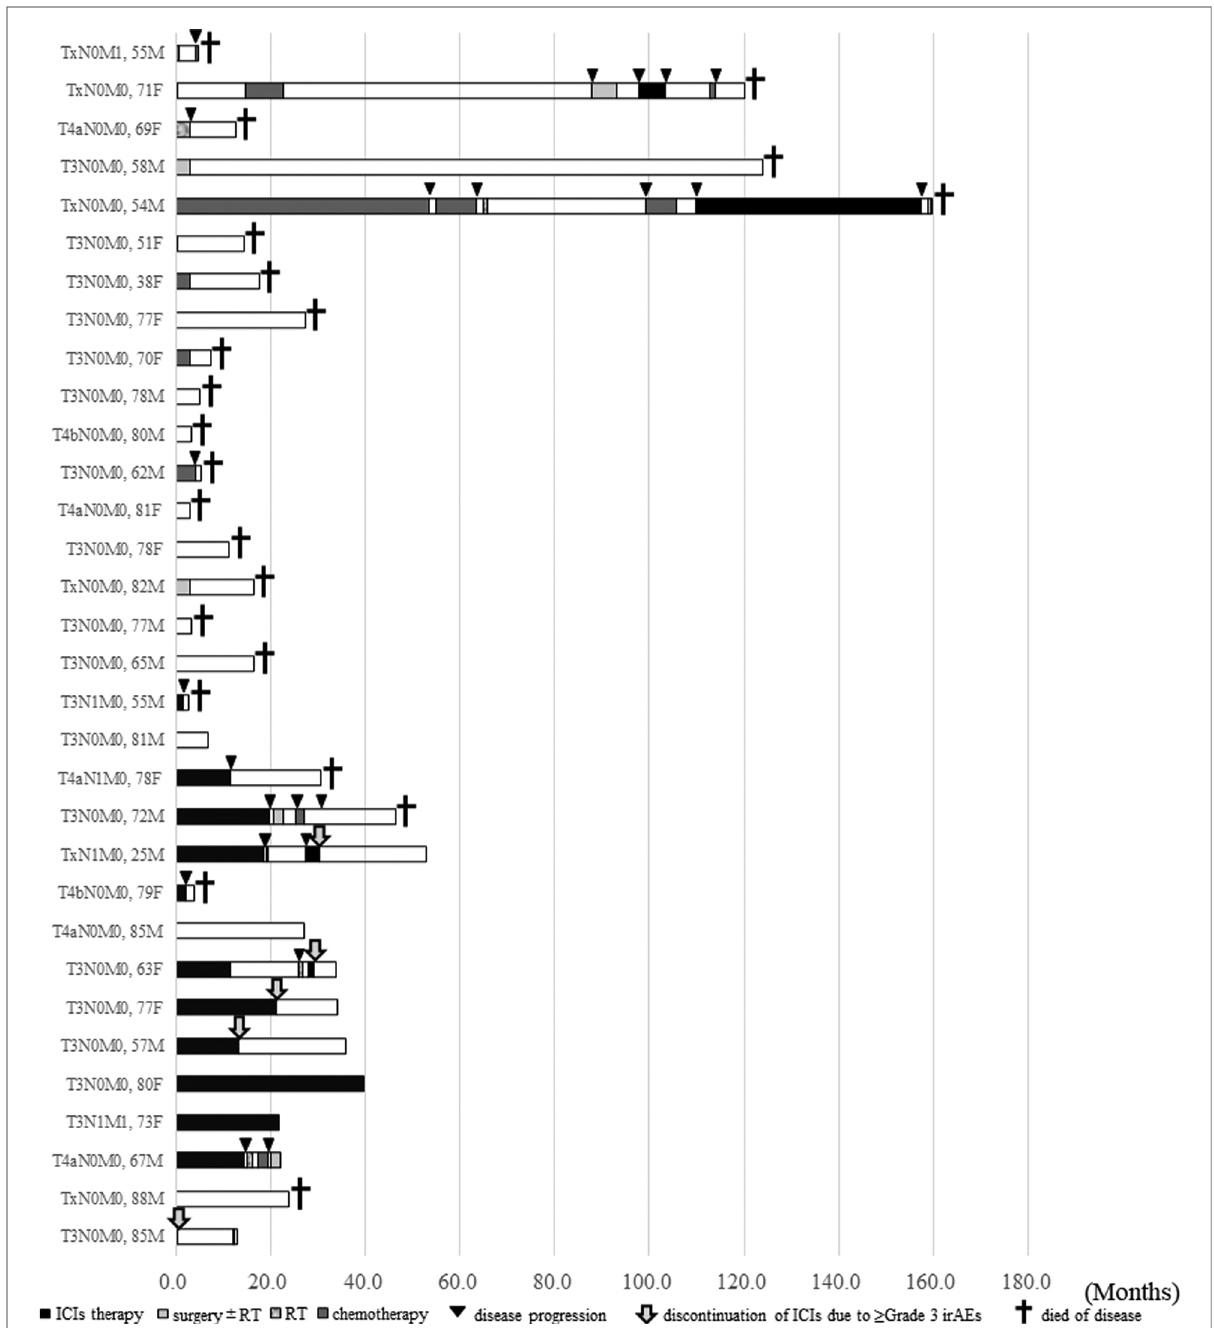
FIGURE 4. Swimmer plot showing the detailed clinical courses of patients with advanced HNMM ( n =32). The data are shown in chronological order of treatment initiation for advanced disease. Black bars; the period of ICIs therapy. Light gray bars; the period of salvage surgery±following radiotherapy. Striped gray bars; the period of radiotherapy. Dark gray bars; the period of chemotherapy. White bars; off treatment, Black triangles; disease progression. Gray arrow; the onset of irAEs ( ≥ Grade 3) Black cross; Died of